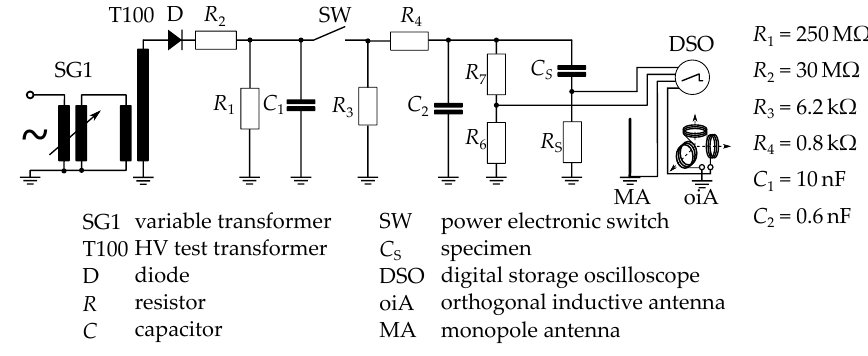
Figure 3. Circuit diagram for the measurement